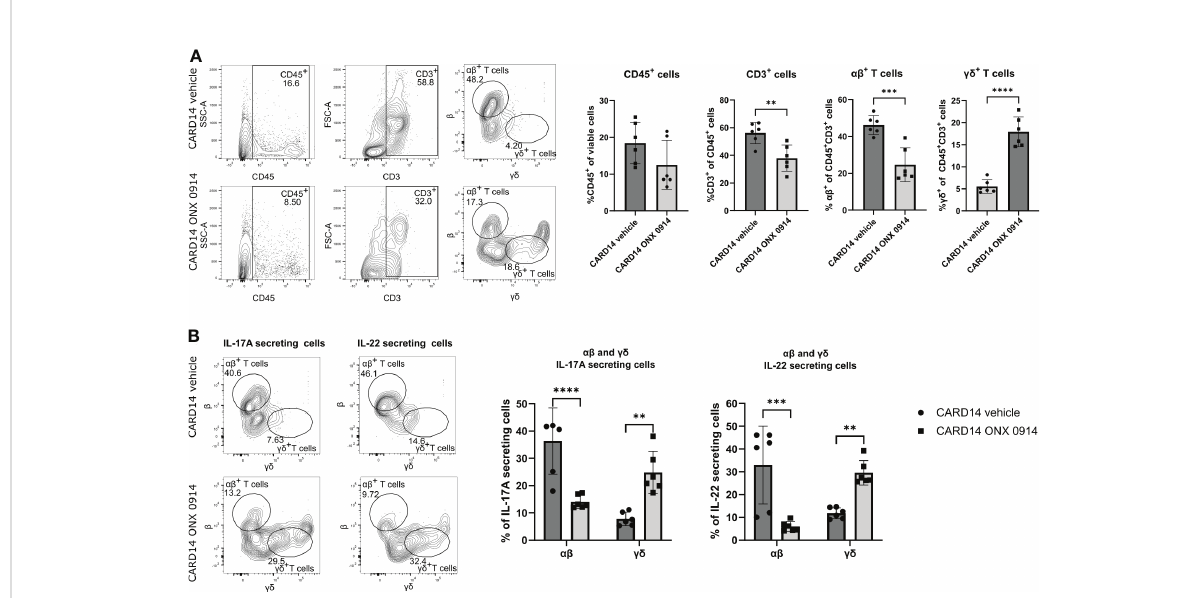
FIGURE 4 Immunoproteasome inhibition alters the ab + and gd + T cell subsets. 8-10 weeks old Card14 D E138 +/- mice were treated on alternate days with ONX 0914 (n = 6) or vehicle (n = 6) for 20 days. A single cell suspension of the ear was prepared and stimulated with PMA, ionomycin and BFA for 4 hours at 37°C. Then, an intracellular cytokine staining for IL-17A and IL-22 was performed. The ab + or gd + were gated on CD45 + CD3 + cells. (A) Quanti fi cation of the frequencies of the analyzed cells. On the g -axis, the percentage of the indicated population of viable or of CD45 + CD3 + cells is depicted. Representative fl ow cytometry plots are shown on the left panel. ab + and gd + cells were gated on CD45 + CD3 + cells after doublet and dead cell exclusion. (B) IL-17A and IL-22 secreting ab + or gd + T cells. Representative fl ow cytometry plots are shown on the left panel. ab + and gd + cells were gated on CD45 + and IL-17A + or IL-22 + cells after doublet and dead cell exclusion. Data were pooled from two independent experiments and analyzed by unpaired t-test (A) or two-way ANOVA followed by a S ̌ ida ́ k test (B) . The gating strategy is depicted in Supplementary Figure 3D. Gating was performed using FMO spleen samples. IL-17A and IL-22 secretion was gated using FMO ear samples. All values represent mean ± SD. * p < 0.05, ** p <0.01, *** p < 0.001, and **** p <